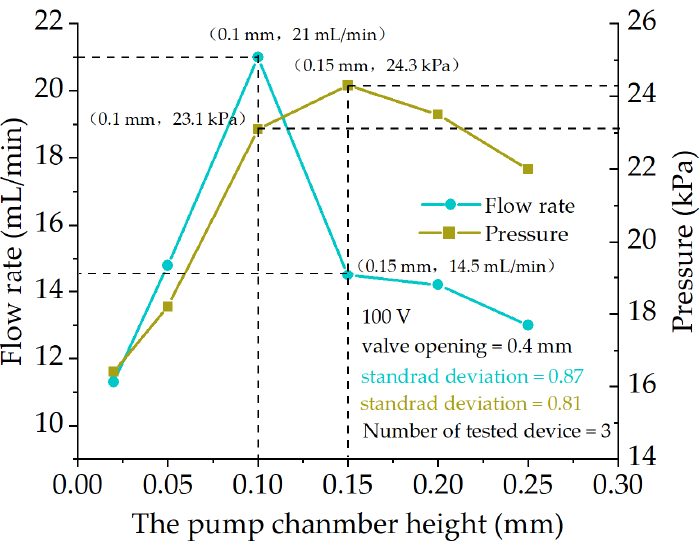
Figure 7. Output performance of micropump with different chamber heights.